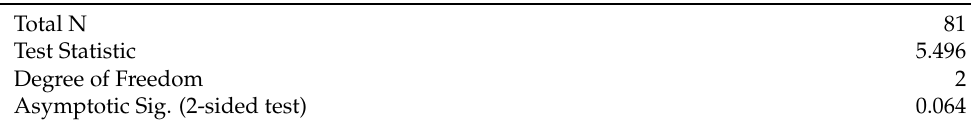
Table 7. Related samples Friedman’s two-way ANOVA by ranks, summary. Total N